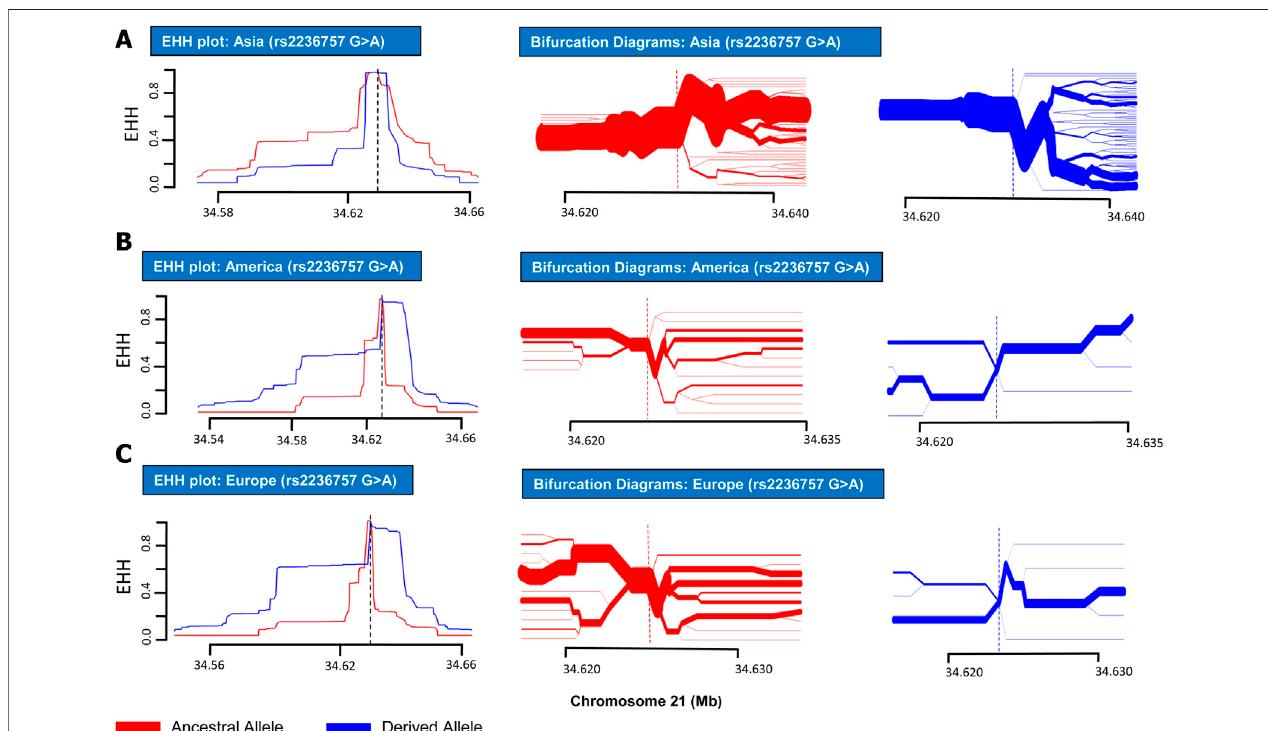
FIGURE1| EHHplotsandBifurcationDiagramsforSNPrs2236757(innon-AfricanPopulations).EHHplotsandBifurcationDiagramsforSNPrs2236757inAsian (A) , American (B) and European (C) populations. EHH = l on Y-axis indicates all haplotypes carrying either ancestral or derived state of the allele are matching upto this point. X-axiscontainscoordinatesforhumanchromosome21.Ancestralalleleisshownbeforethederivedallele,separatedbya “ > ” symbol.IntheEHHplots,smallerareaunderthe curve for both ancestral and derived alleles (G > A) shows no signs of recent positive selection in any of the aforementioned populations.